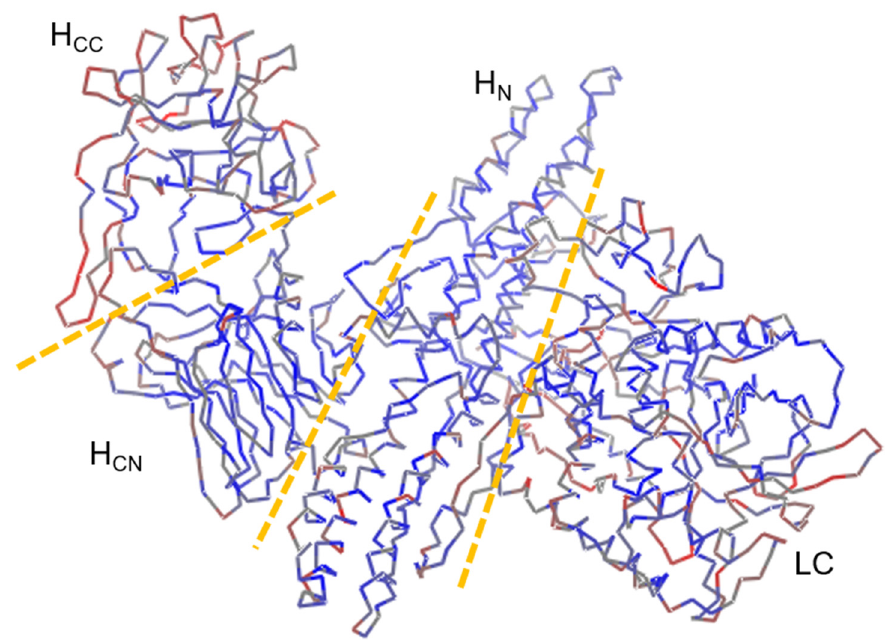
Figure 3. Amino acid sequence diversity of BoNT proteins mapped on its 3D structure (3BTA, serotype A). The diversity index, the actual counts of the number of unique amino acids or nucleotides of each column in the multiple alignment files, of all the positions were mapped on the 3D structure of a reference gene, 3BTA, downloaded from the PDB database. The diversity index is indicated by different shades of a color from blue (low) to medium (grey) to red (high). LC: Light chain. H N : Heavy chain N-terminus. H CN : N-terminus of heavy chain C-terminus. H CC : C-terminus of heavy chain C-terminus.